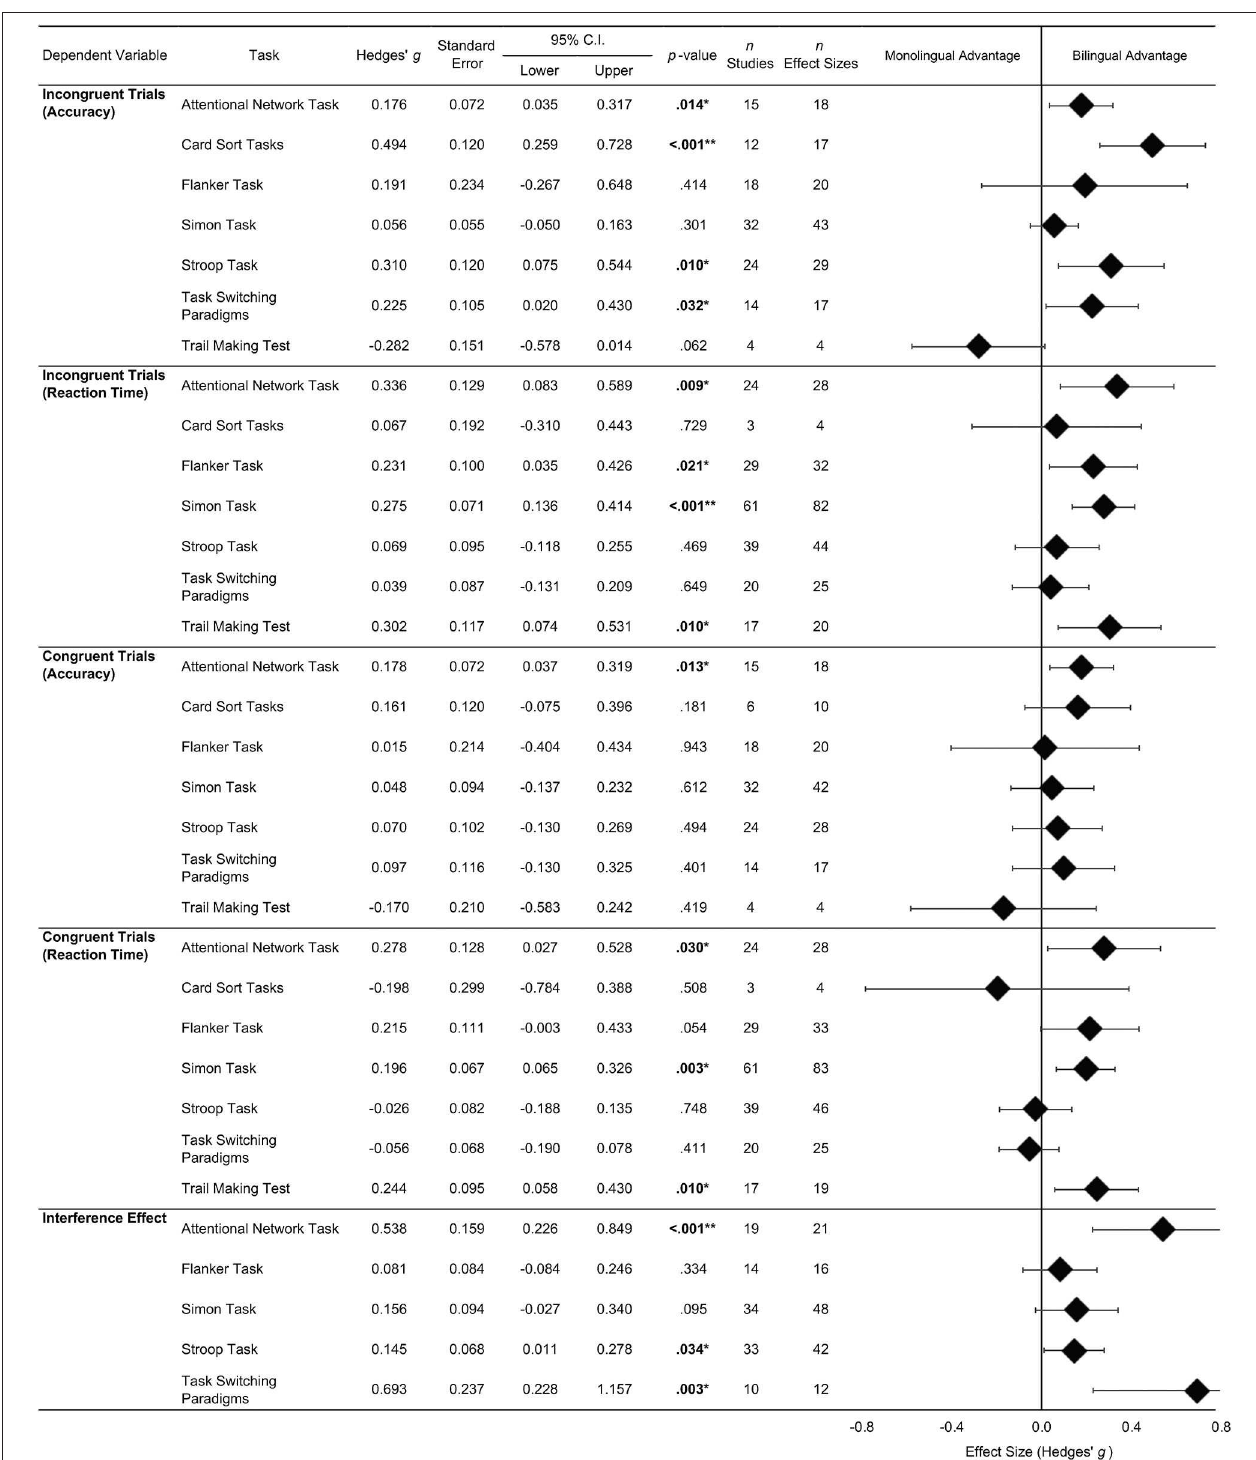
FIGURE 4 | Average effect sizes reported by Task, Trial Type, and for accuracy and reaction time data. No interference effect/cost effect sizes were available for the Card Sort Tasks and Trail Making Test. * p < 0.05; ** p < 0.001.